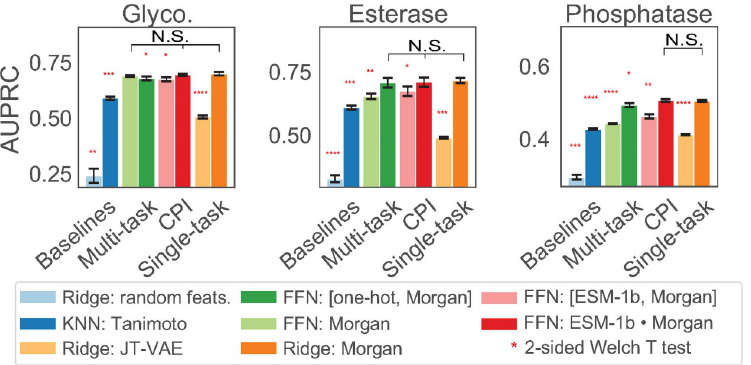
Fig 3. Assessing substrate discovery in family wide screens. CPI models and single task models are compared on the glycosyltransferase, esterase, and phosphatase datasets, all with 5 trials of 10-fold cross validation. Error bars represent the standard error of the mean across 3 random seeds. Each model and featurization is compared to “Ridge: Morgan” using a 2-sided Welch T test, with each additional asterisk representing significance at [0.05, 0.01, 0.001, 0.0001] thresholds respectively, after applying a Benjamini-Hochberg correction. Pretrained substrate featurizations used in “Ridge: JT-VAE” are features extracted from a junction-tree variational auto-encoder (JT-VAE) [53]. Two compound protein interaction architectures are tested, both concatenation and dot-product, indicated with “[{prot repr.}, {sub repr.}]” and “{prot repr.}•{sub repr.}” respectively. In the interaction based architectures, ESM-1b indicates the use of a masked language model trained on UniRef50 as a protein representation [20]. Models are hyperparameter optimized on a held out halogenase dataset. AUCROC results can be found in Fig D in S1